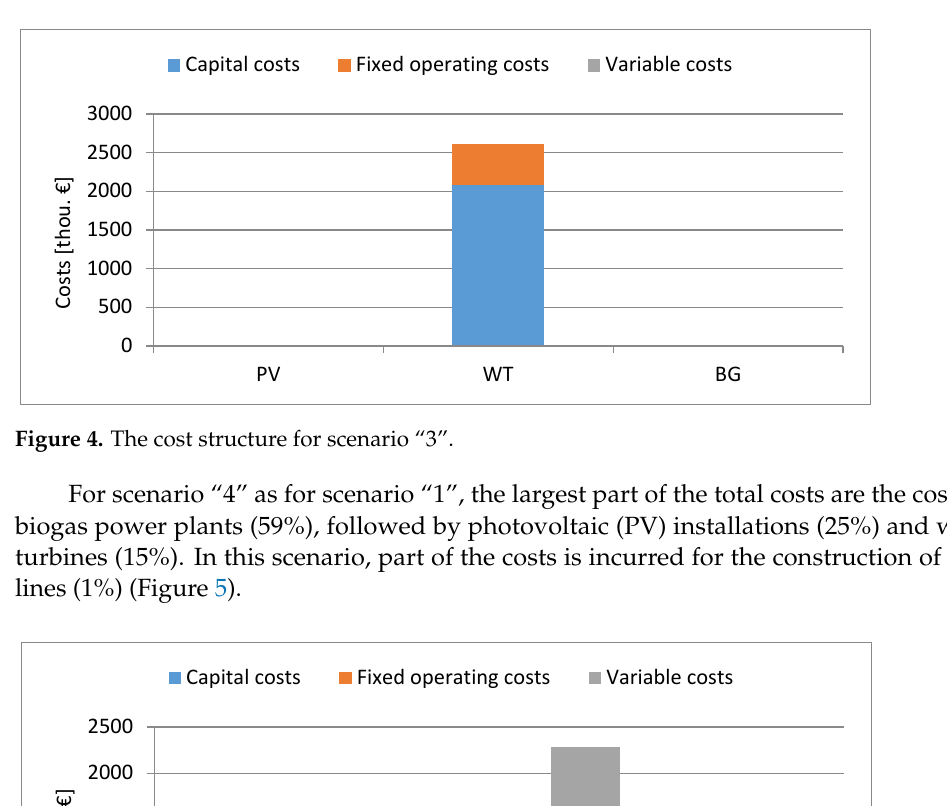
Figure 6. The cost structure for scenario “5”. The highest costs of development of the analyzed distribution system were obtained for scenario “1”, for which only the selection of power and quantity of RES in nodes was assumed. By adding the selection of capacity and the number of energy storages in the nodes, the overall costs were reduced by 14%. For scenario “3” an additional 21% cost reduction was achieved. The lowest cost reduction in relation to the first scenario was achieved for the 4—4% scenario. However, by assuming all actions together (scenario 5), the lowest system development costs were obtained, which were 48% lower than the costs obtained for scenario “1” (Figure 7). Figure 7 Total costs of the development of the distribution system.